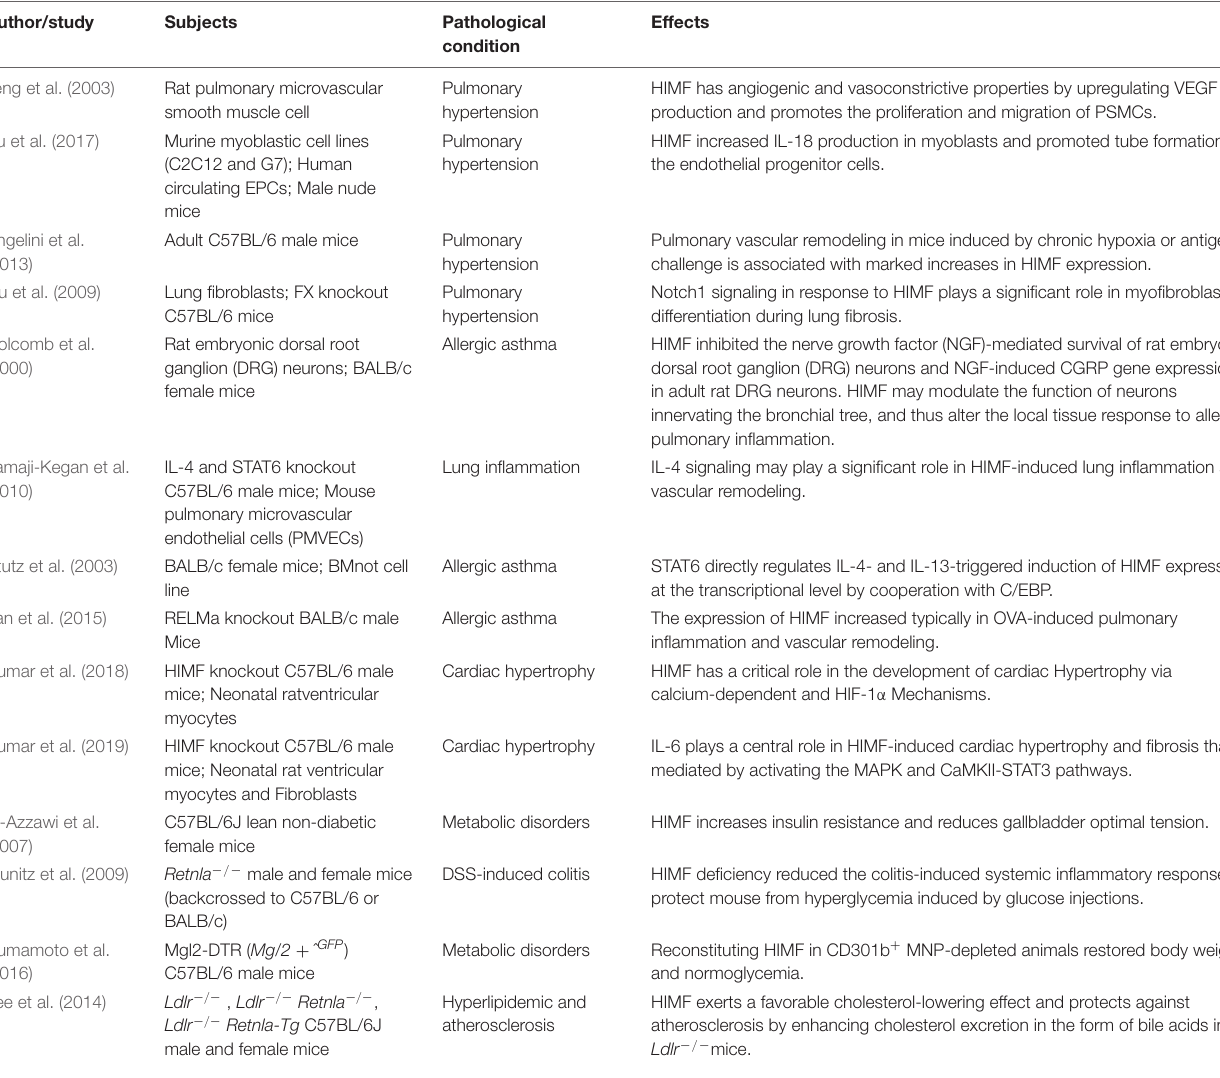
TABLE 1 | Presentation of the studied diseases relating to